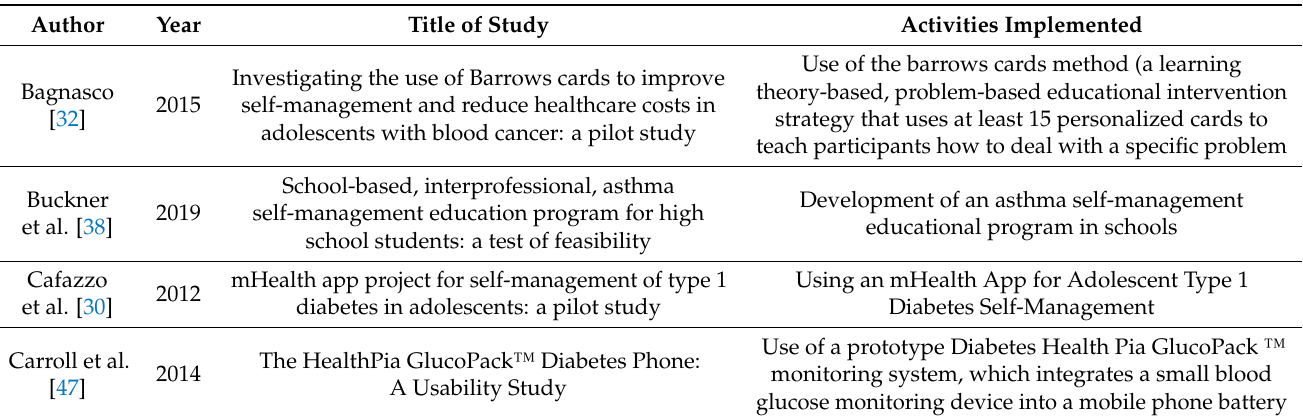
Table A5. Activities implemented and evaluated to promote self-management of children and adolescents in health